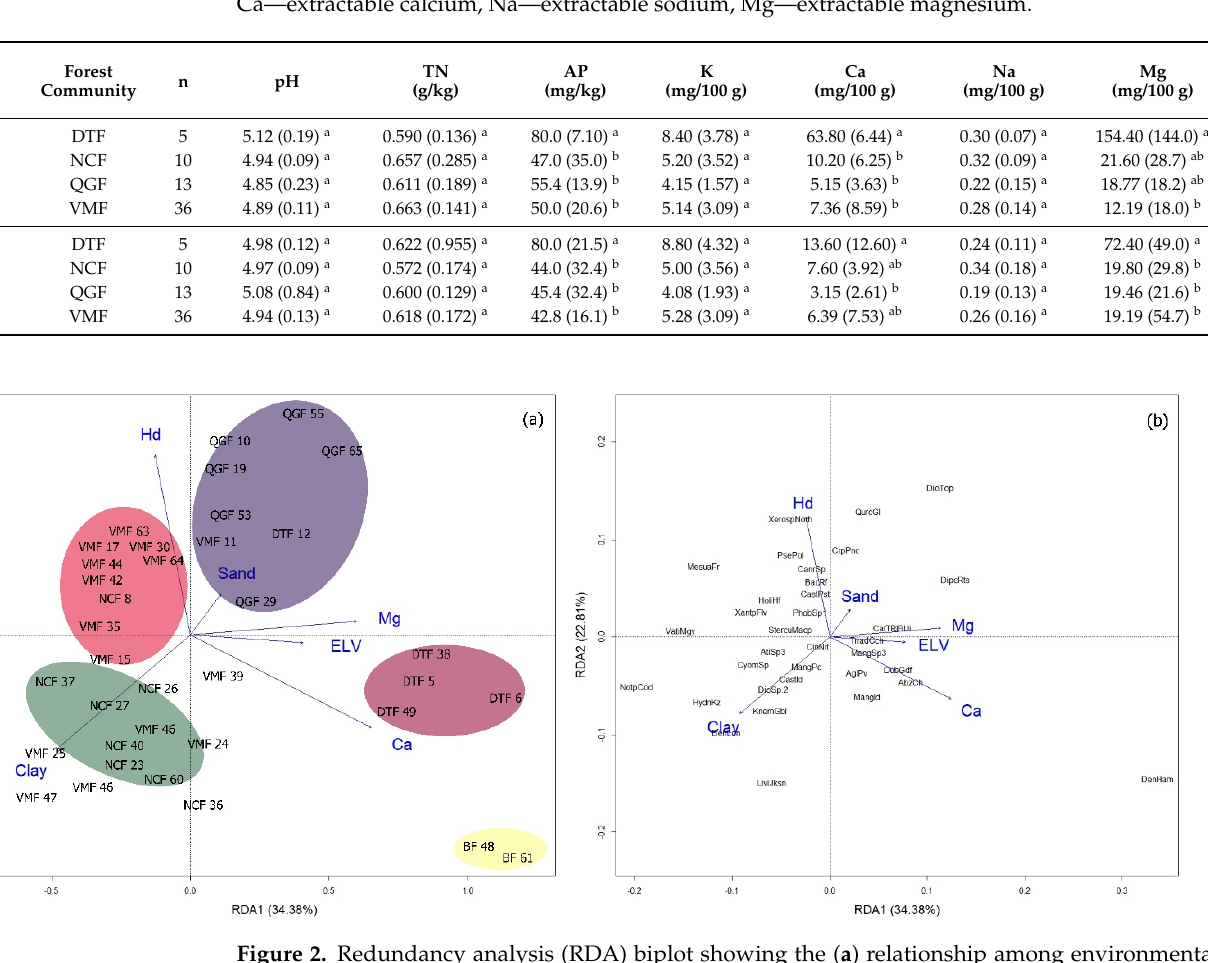
Figure 3. Redundancy analysis (RDA) biplot showing the ( a ) relationship among environmental variables and forest communities and ( b ) relationship among environmental variables and domi- nant tree species at 15 - 30 cm soil depth in Htamanthi Wildlife Sanctuary in Myanmar. Abbrevia- tions: ELV - elevation, Hd - soil hardness, Mg - extractable magnesium, Ca - extractable calcium; forest communities: Vatica maingayi forest (VMF), Quercus glauca forest (QGF), Nothaphoebe condensa forest (NCF), and Diospyros toposia forest (DTF). The number after the abbreviated name of the forest community in panel ( a ) indicates the plot number. In panel ( b ), the black lowercase letters indicate the abbreviated scientific names of dominant tree species (Table S1). 3. Discussion